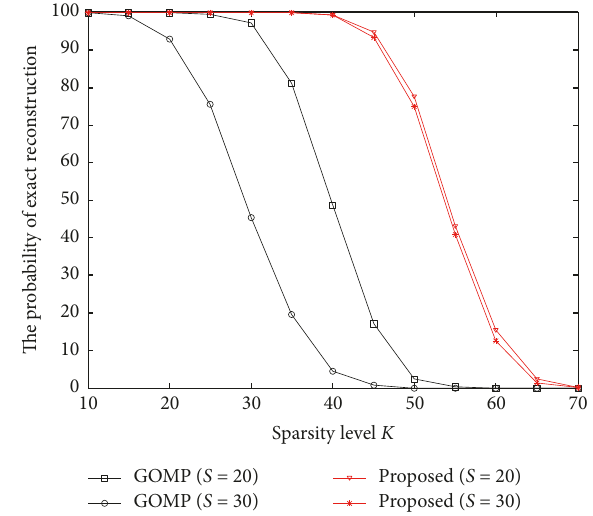
Figure 2: Reconstruction performance of GOMP and the proposed method with a small 𝑆 value.